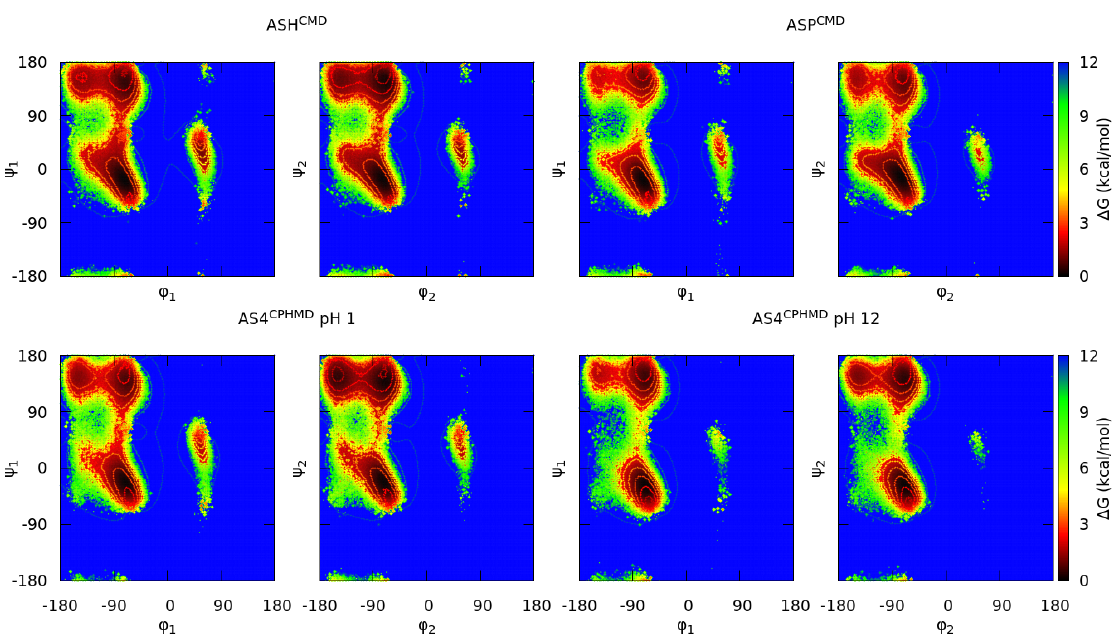
Figure 6. Gibbs free energies in the Ramachandran space of the blocked Lys 2 tripeptide. Each subtitle indicates the residue, the simulation method (in the superscript), and the pH (only for the CPHMD simulations). Both sets of dihedrals ( ϕ 1 / ψ 1 from the N-terminal amino acid; ϕ 2 / ψ 2 from the C-terminal amino acid) are illustrated. Protonated forms are on the left (CMD; top—CPHMD; bottom) and deprotonated ones are on the right (CMD; top—CPHMD; bottom). Solid lines indicate an increase of 0.6 kcal/mol of the energy values.